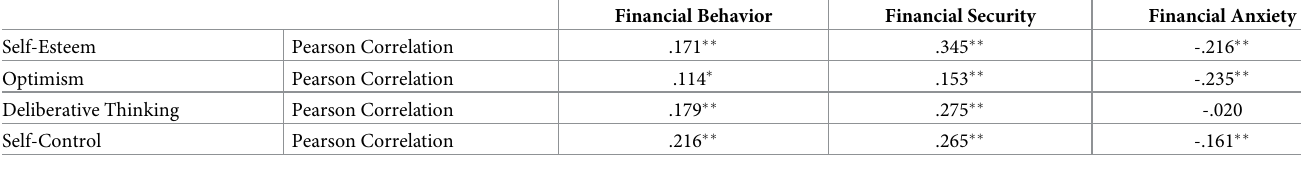
Table 2. Two-tailed correlations among predictors and dependent